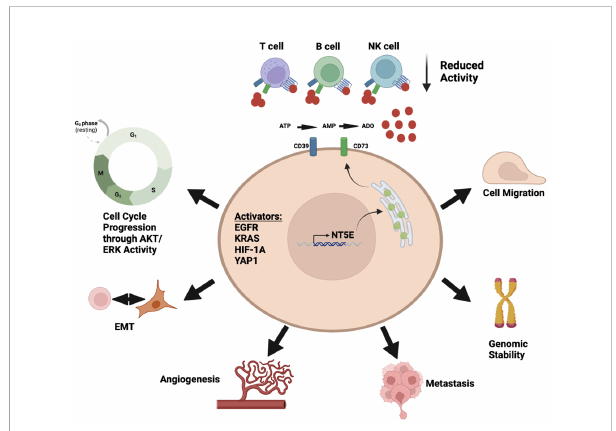
FIGURE 1 Diverse roles of adenosine pathway in the tumor microenvironment. Illustration was created using